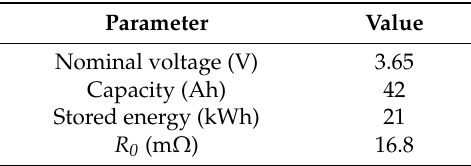
Table 2. Basic parameters of the battery cell.